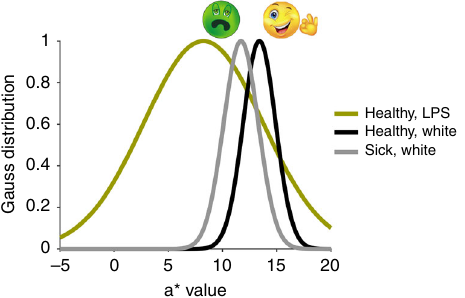
Fig. 8 Probability of a * values given health or sickness and lighting condition. The probability distribution for healthy skin under sodium light was generated using participant matches of masked forehead. Gaussian distributions for healthy and sick faces were obtained from the mean and standard deviation of measurements of cheek and forehead provided by Henderson et al. 25 . Source data are provided as a Source Data fi le. Smiley emoticon with OK sign created by Tigatelu with Dreamstime.com. All rights reserved. Sick Emoji created by hypothesis is supported by an analysis of color vision, skin color, pelage color, and social systems traits among primates, which suggests that the potential for trichromatic vision existed before the evolution of traits used in social communication, but once trichromacy evolved, it promoted the evolution of red traits (including hair loss on the face) through sexual selection 53 . The results presented here do not refute a role of color in detecting, discriminating, recognizing, and remembering objects, scenes, or fruit 2,11,54 , but they help resolve the relative value of color by showing that trichromatic color signals from the face are espe- cially important for behavior. The results lend weight to the idea that regardless of the selective pressures that drove the initial evolution of trichromacy in old world primates, trichromacy has been maintained because of its role in social signaling. the lighting on the stimuli was consistent across participants: stimuli were placed at